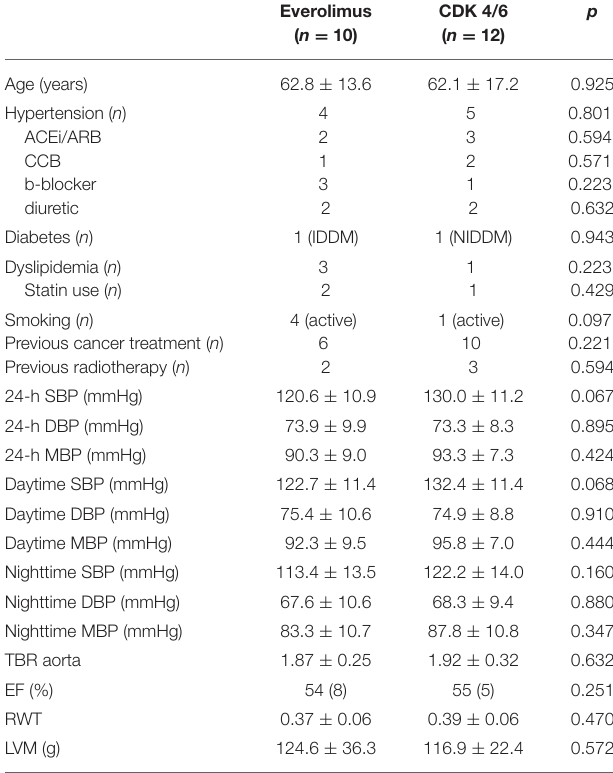
TABLE 1 | Baseline